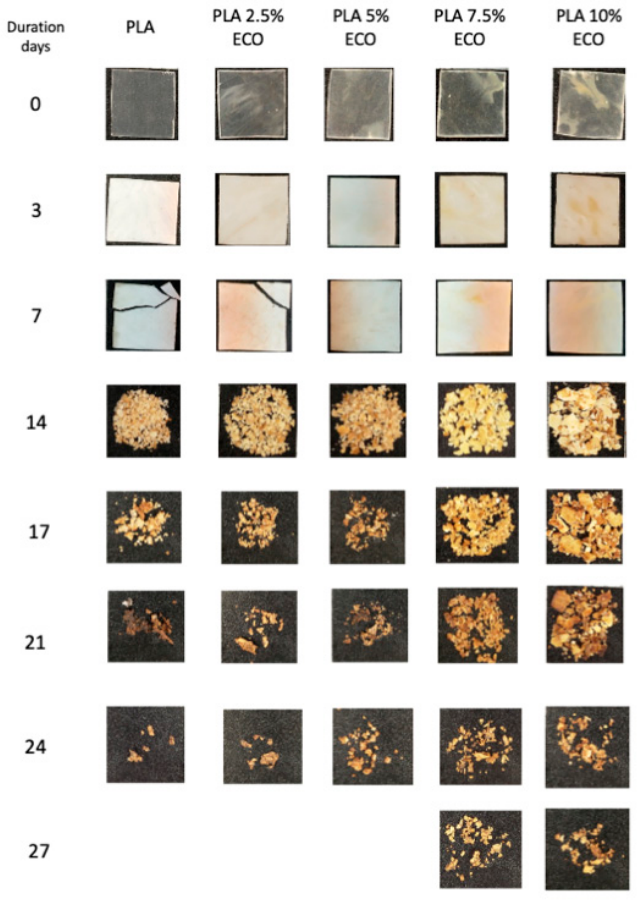
Figure 8. Visual appearance of disintegration under composting conditions.